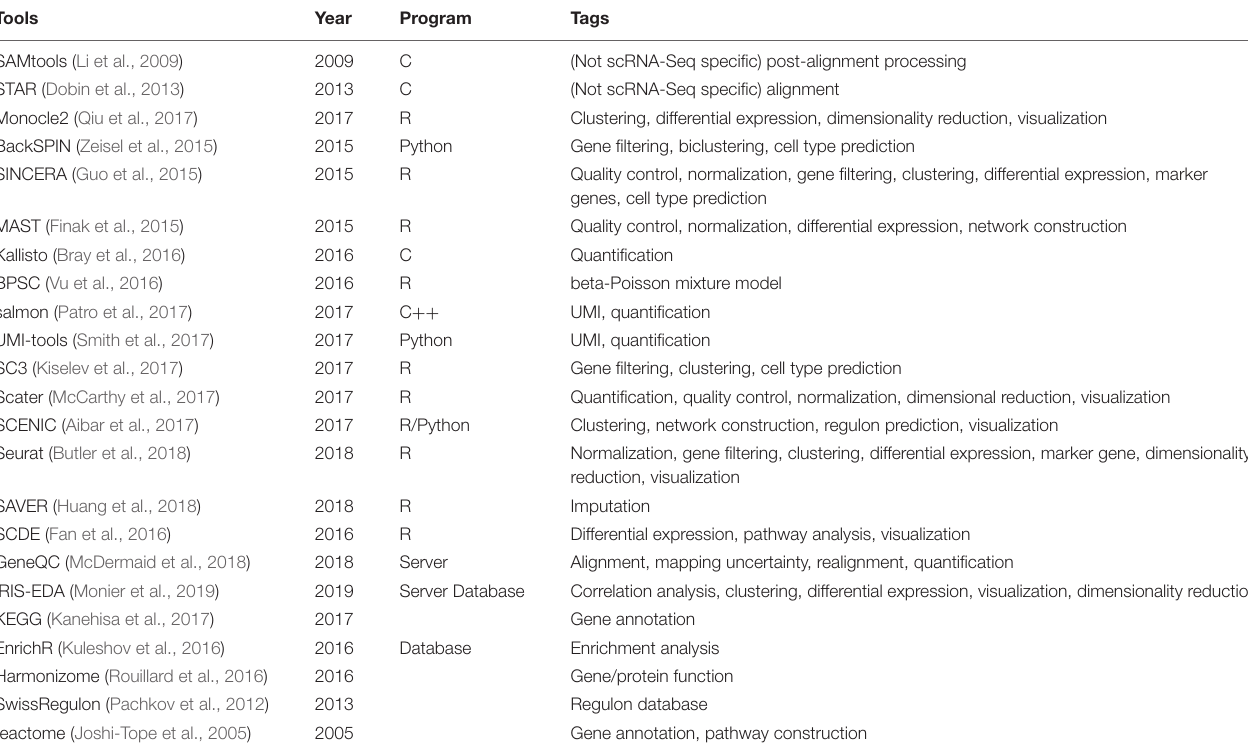
TABLE 1 | Summary of popular analytical tools for